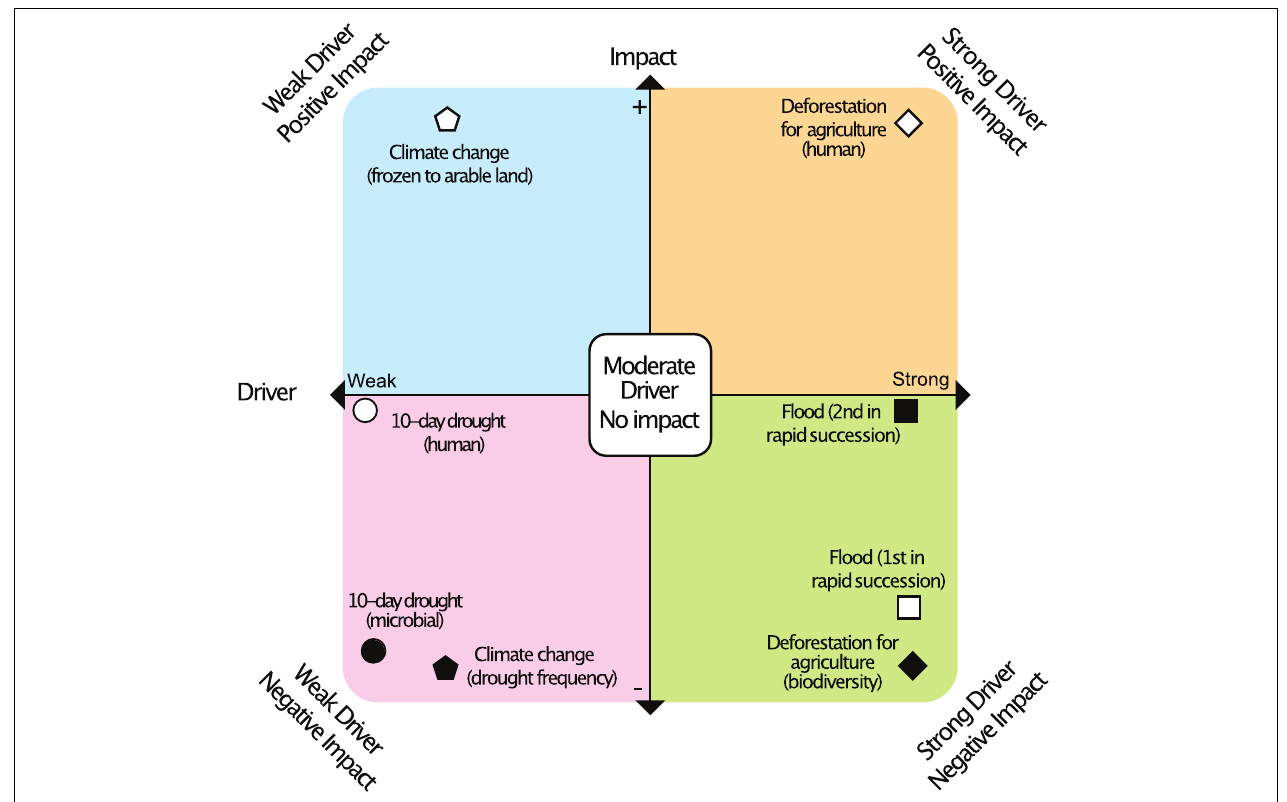
FIGURE 1 | Current disturbance lexicon conflates two distinct processes—events that drive ecological change and impacts of extreme events—both interchangeably termed disturbances despite fundamental distinctions between the two types of processes. We disentangle these processes to derive four universal types of disturbances that are applicable regardless of the line of inquiry or its spatiotemporal scale. Drivers ( x -axis) are defined as a force, either biotic or abiotic, that deviates from local, prevailing background conditions. A driver is characterized by its magnitude of deviation from an environmental baseline (low to high deviation denotes weak to strong driver). Impacts ( y -axis) are defined as the impact of social-ecological consequences of a driver relative to a scale-dependent baseline state. Impacts can be positive or negative depending on the perspective of the study. Each quadrant is, therefore, a unique disturbance type defined in more detail in Table 1 , and the position of drivers and impacts across and within the quadrants slides with the line of inquiry. Examples of disturbances across spatial and temporal scales are denoted within each quadrant.